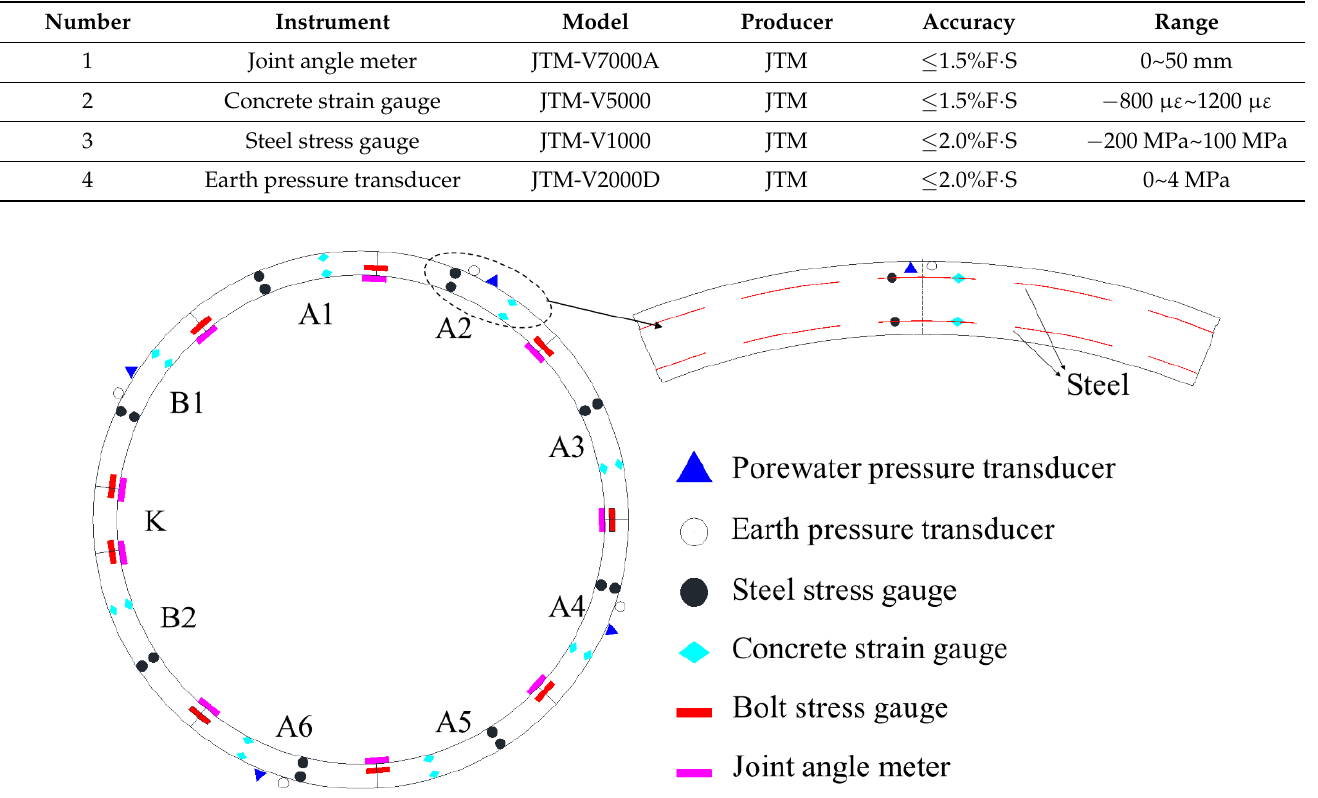
Figure 7. Schematic layout of component measurement points.